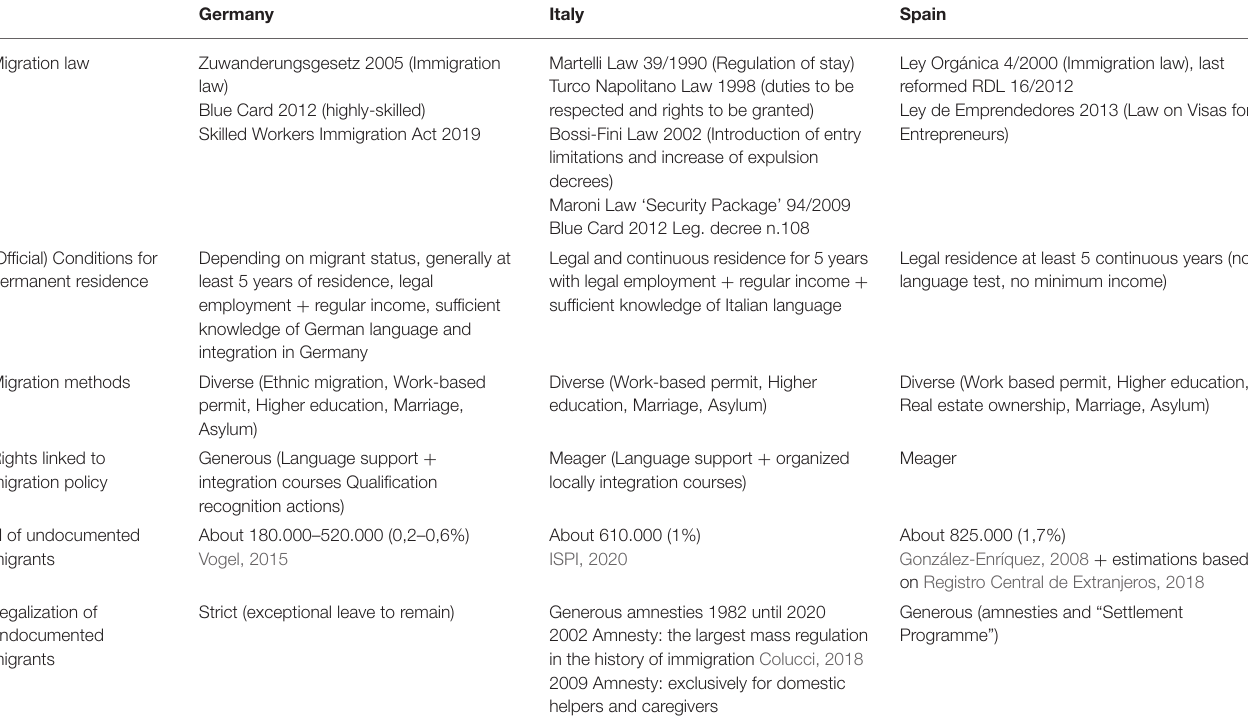
TABLE 1 | Overview of migration policy regulations in Germany, Italy, and